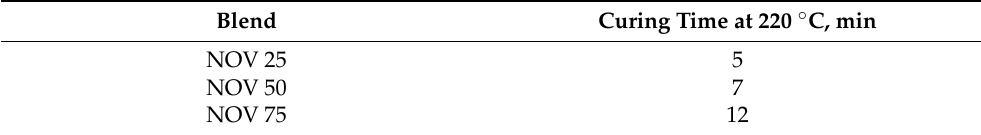
Table 1. Curing time of blends at 220 ◦ C. Blend Curing Time at 220 ◦ C, min